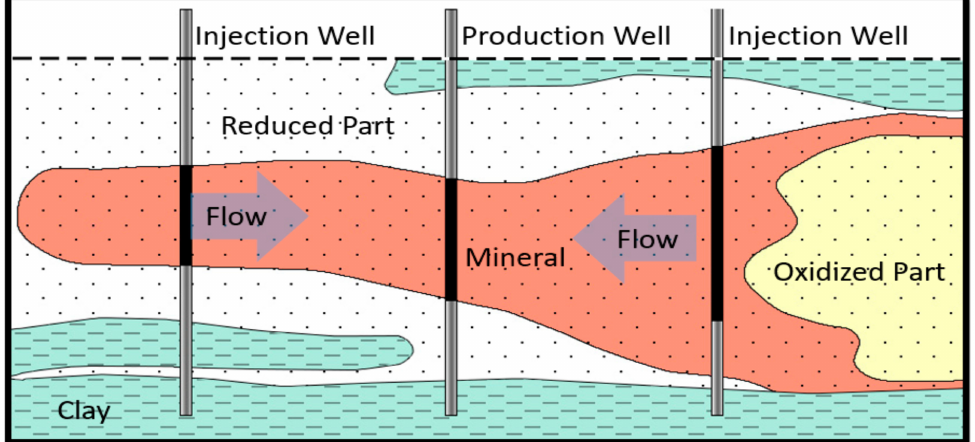
Figure 1. Section view of in situ leaching